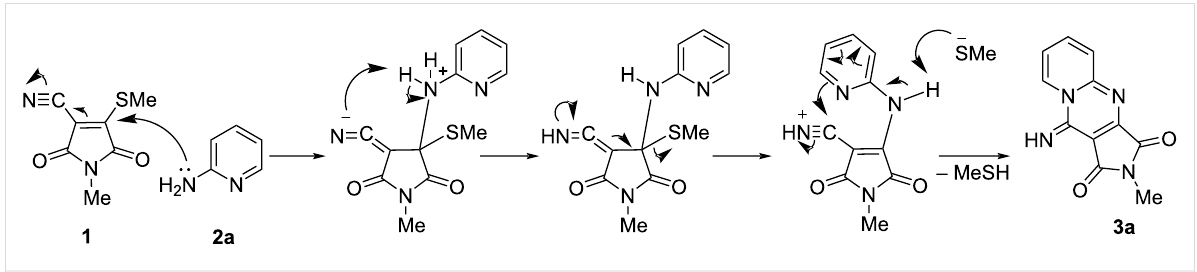
Figure 1: Presumed reaction mechanism to produce 3a